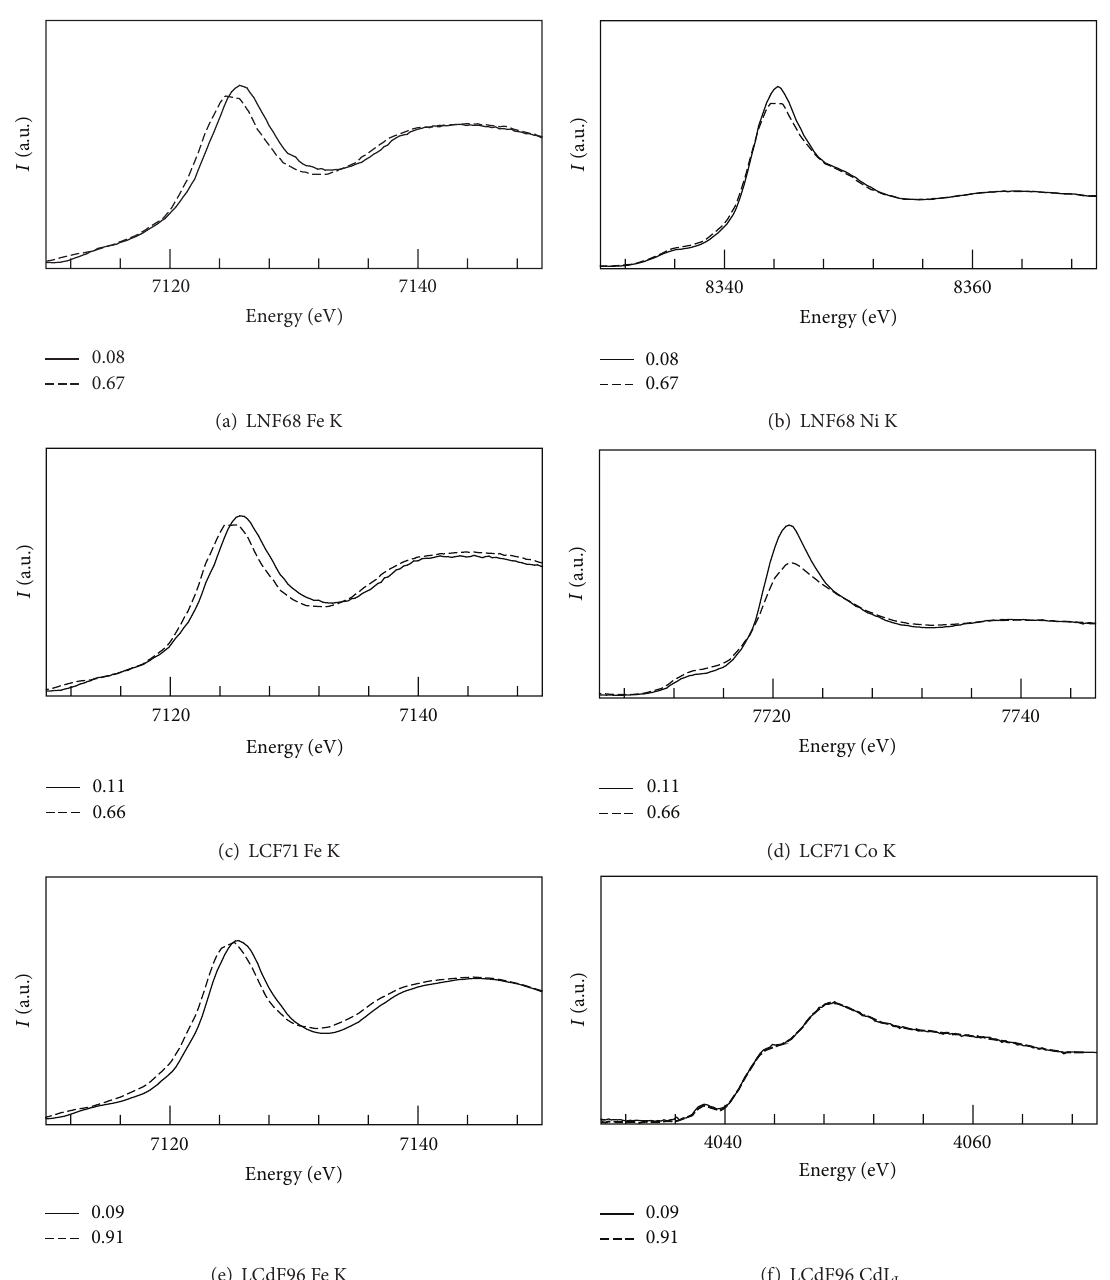
Figure 15: XAS spectra of LNF68 films against 𝑥 around the (a) Fe K- and (b) Ni K-edges. XAS spectra of LCF71 films against 𝑥 around the (c) Fe K- and (d) Co K-edges. XAS spectra of LCdF96 films against 𝑥 around the (e) Fe K- and (f) Cd L I -edges (cited from [21]).